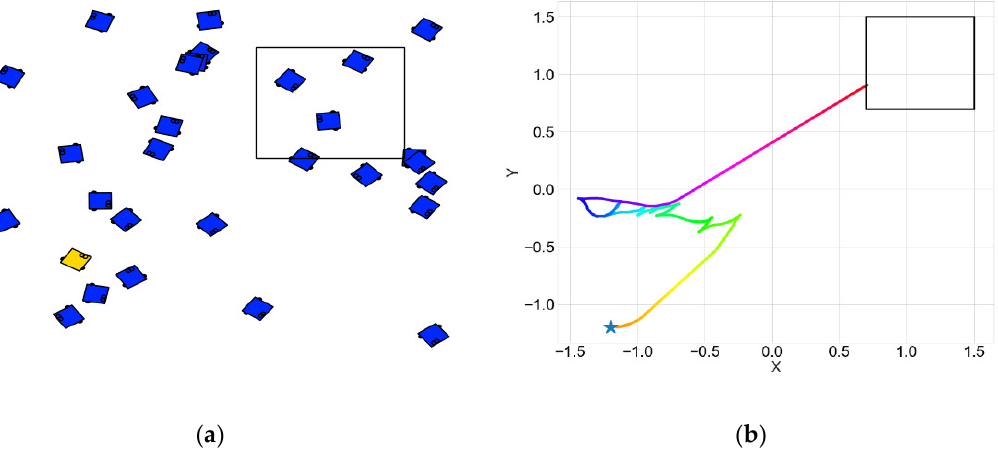
Figure 9. Collision Avoidance Among Multi-Agents. The ego agent is represented as yellow, while